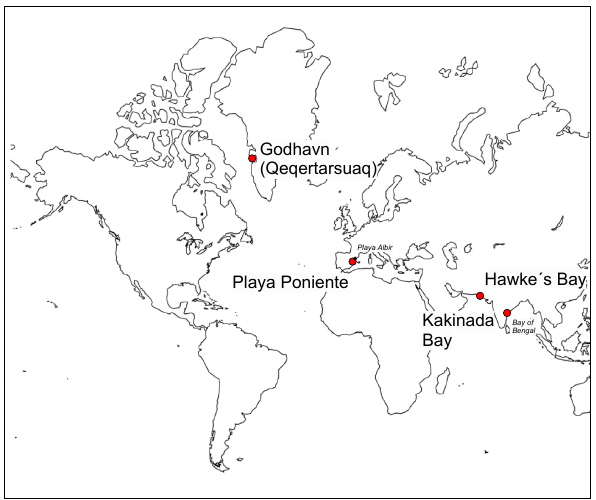
Figure 1. Map with locations where bivalve and seawater samples were